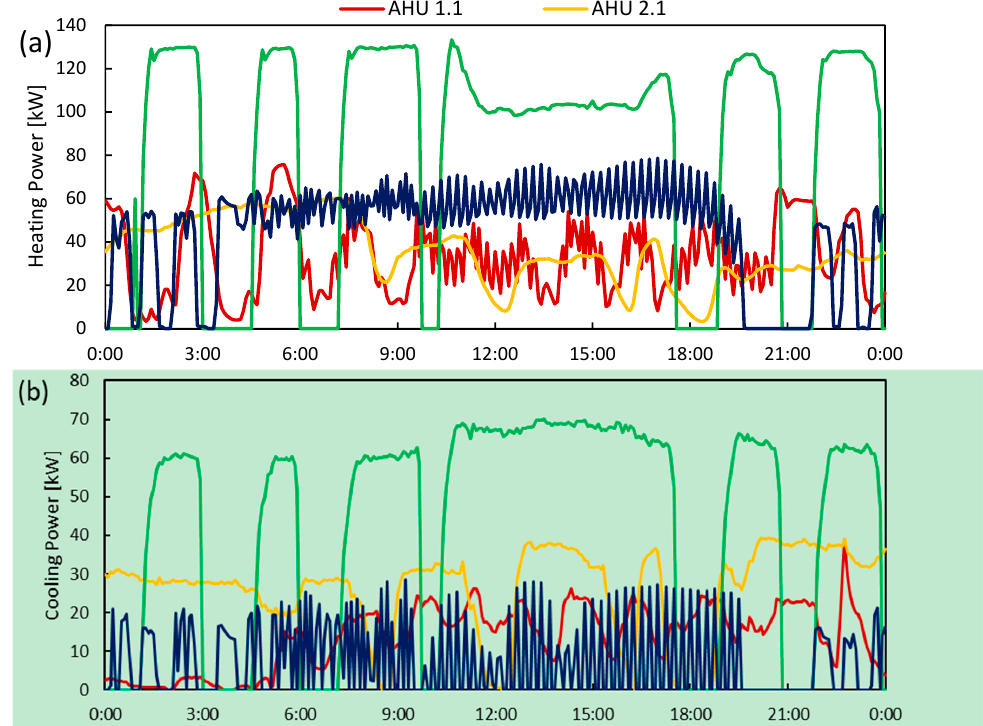
Figure 14. Total external ( a ) heating and ( b ) cooling power used by the AHUs for supply air treatment.